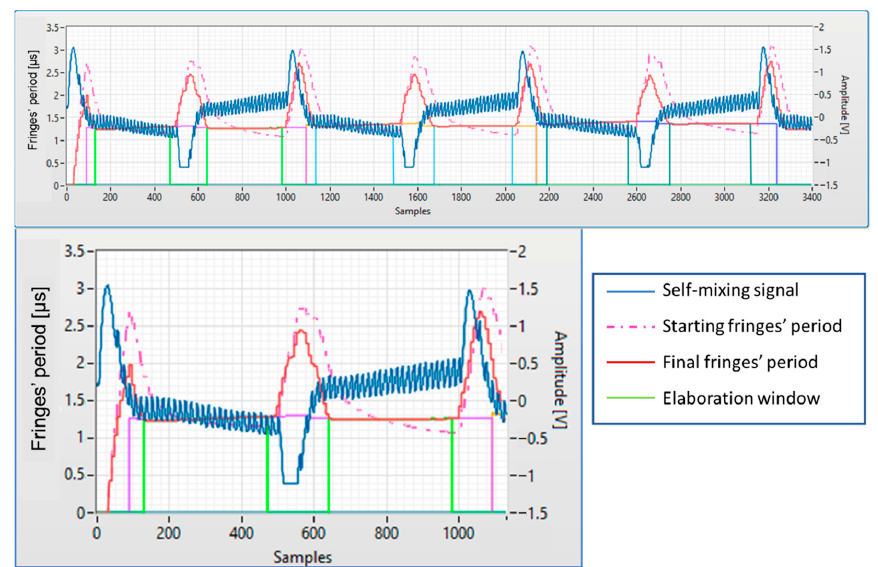
Figure 7. Top panel: a screenshot of the LabVIEW program for calculating the modulation distortions, showing the self-mixing signal, the measured fringes’ frequency, and the original fringes’ frequency (dash-dotted line). Vertical lines indicate the intervals for interpolated FFT execution (elaboration window). Bottom panel: detail of the first 10 kHz modulation.